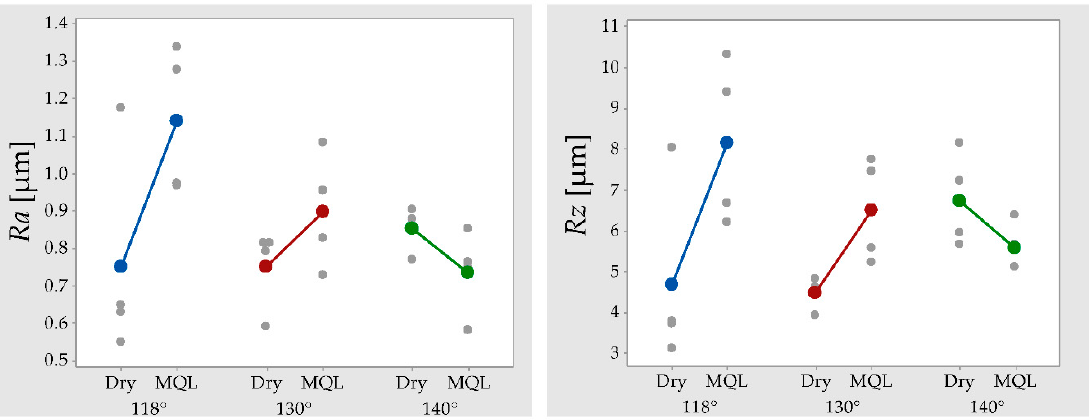
Figure 15. Influence on Ra and Rz of the lubrication type for the different point angles.